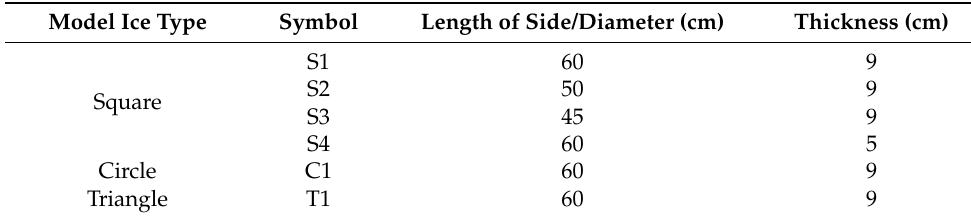
Figure 3. Model ice shapes. ( a ) Square ice floe; ( b ) Circle ice floe; ( c ) Triangle ice floe. Table 1. Model ice